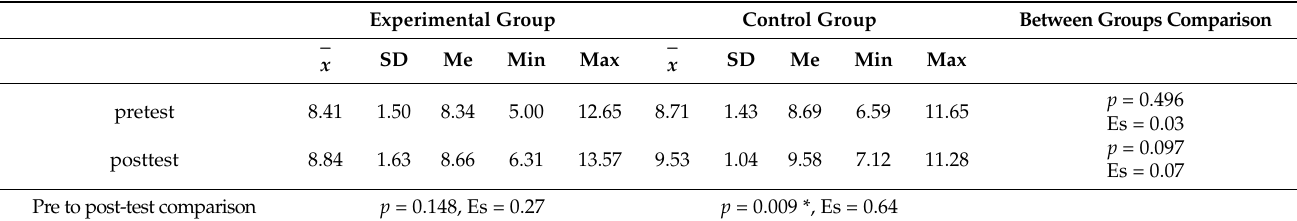
Table 2. Timed Up and Go (TUG) results in the experimental and control groups. Experimental Group